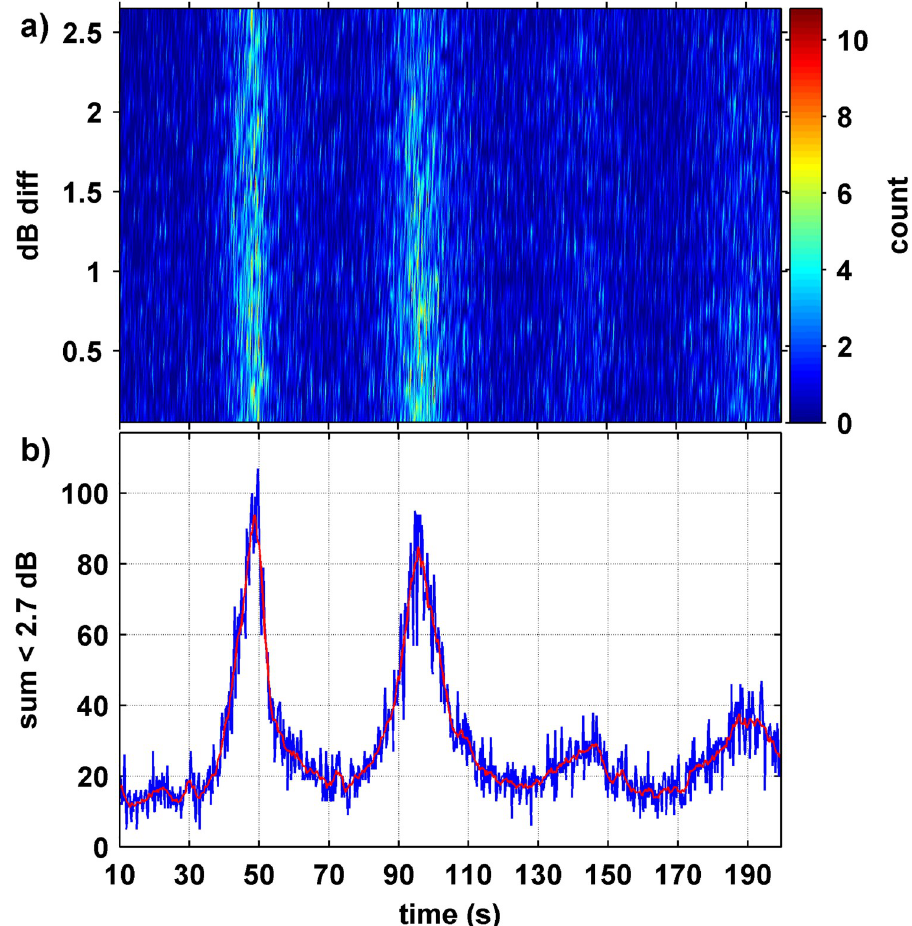
Fig 4. Inter-song-interval analysis. Density distribution (a) of song-to-song time and level differences for consecutive type II units, for 2016 with (b) the curve derived by summing data < 2.7 dB (blue is raw data, red is linearly smoothed data). Panel a) was derived using a 0.25 s and 0.1 dB time and level difference,